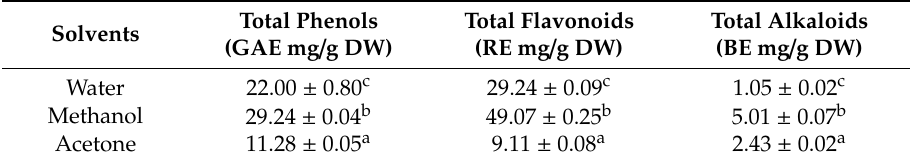
Table 1. TPs, TFs, TAs content of ICM extracted with di ff erent